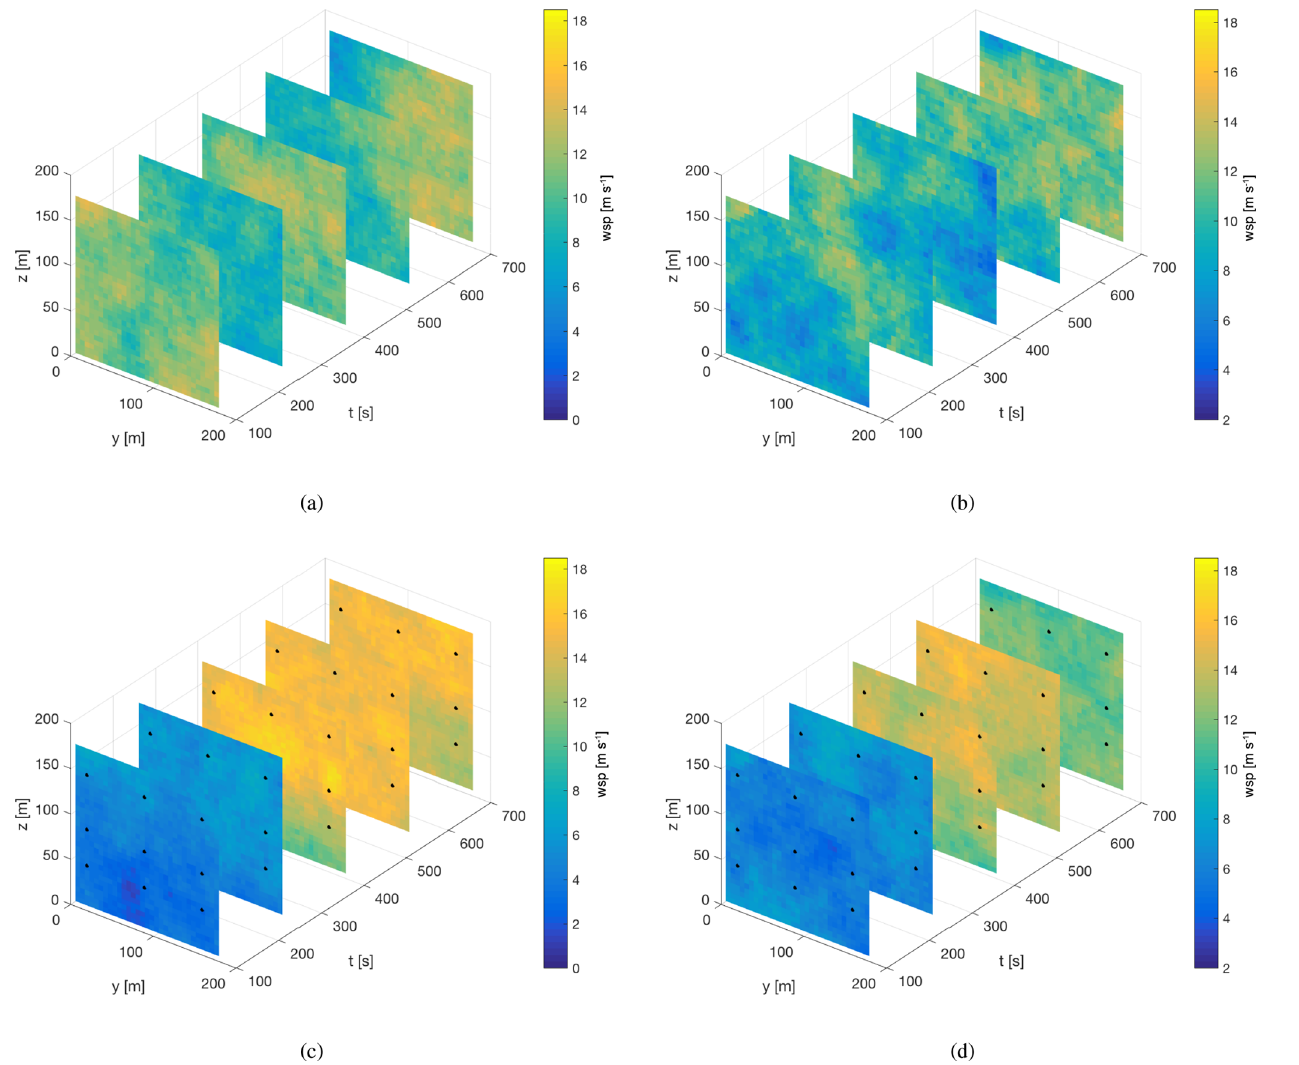
Figure 6. Comparison between u velocity components from unconstrained turbulence simulations and from turbulence simulations with velocity jumps included using the constrained simulation. (a) Seed 1003 without constraints. (b) Seed 1005 without constraints. (c) Seed 1003 with constraints. (d) Seed 1005 with constraints. Constraint locations are shown with black dots.